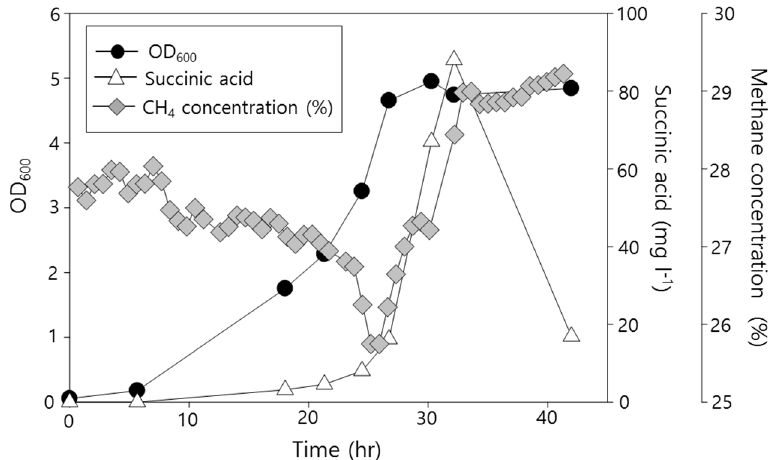
Figure 3. The growth curve and succinic acid production of Methylomonas sp. DH-1. The cells were grown in nitrate mineral salts (NMS) media with a bioreactor where a gas mixture of 30% CH 4 , 55% N 2 , 15% O 2 , was continuously fed at the speed of 40 mL min − 1 . The methane concentration in the reactor off-gas was indicated in the off-set y -axis.